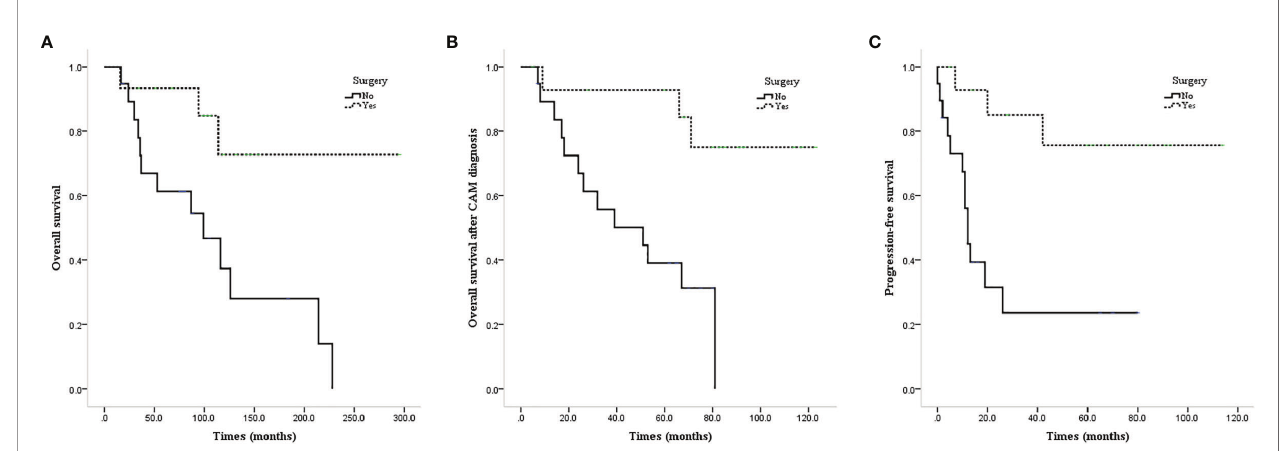
FIGURE 3 | Survival curves of CAM patients based on undergoing axillary surgery or not. (A) OS of CAM patients based on undergoing axillary surgery or not. (B) CAM-OS of CAM patients based on undergoing axillary surgery or not. (C) PFS of CAM patients based on undergoing axillary surgery or not.